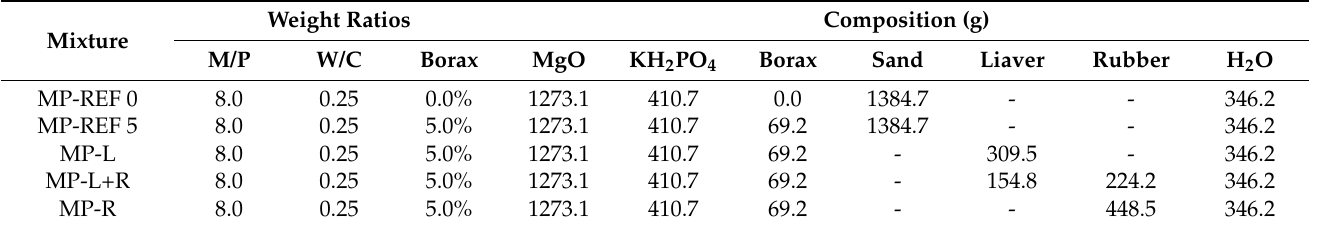
Table 5. Ratios and weight proportion of the developed mortar mixtures.